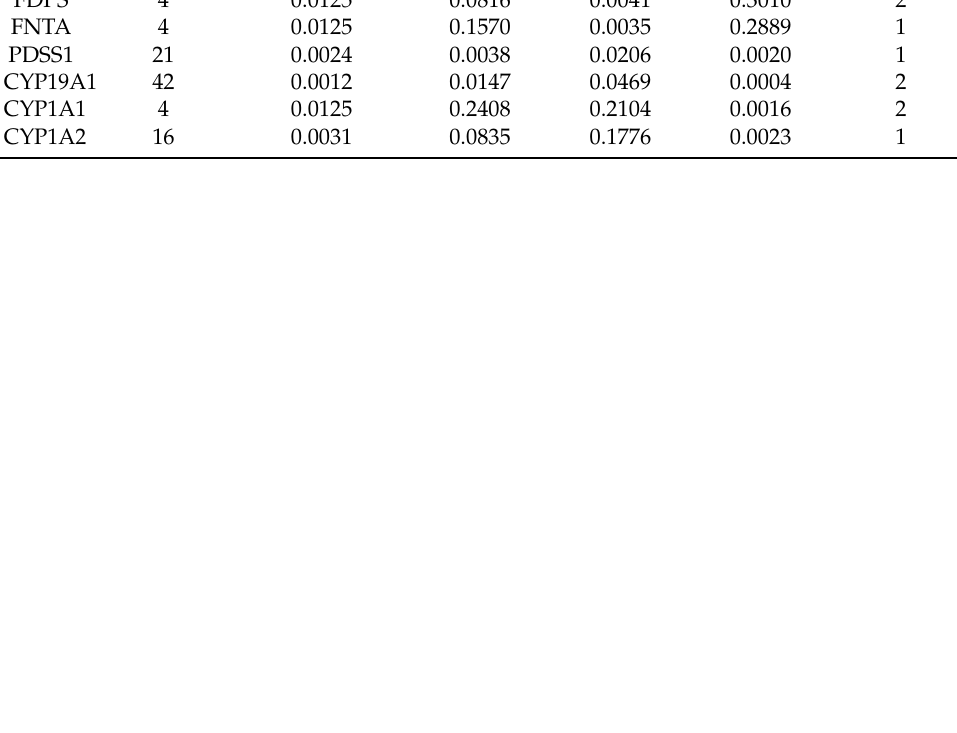
Table 3. SNP association with BMD across genes of the mevalonate and oestrogen pathways.